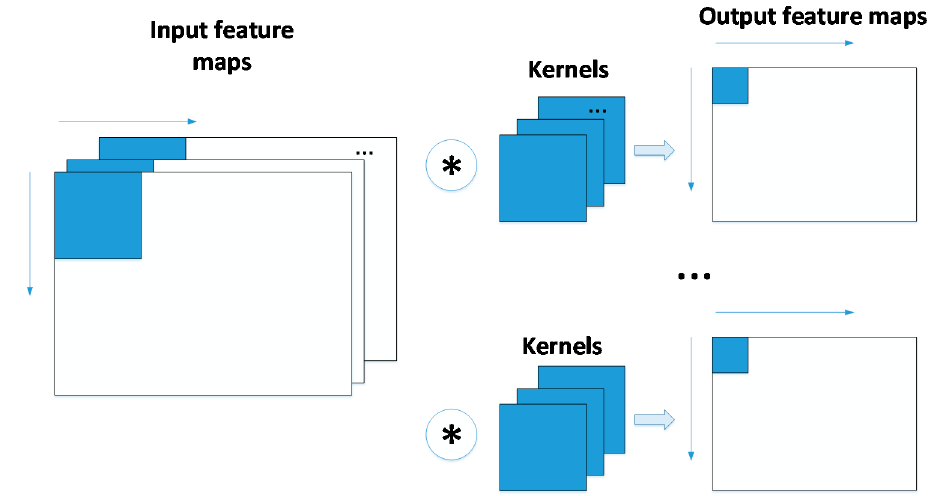
Figure 1. Description of a convolution in CNNs.